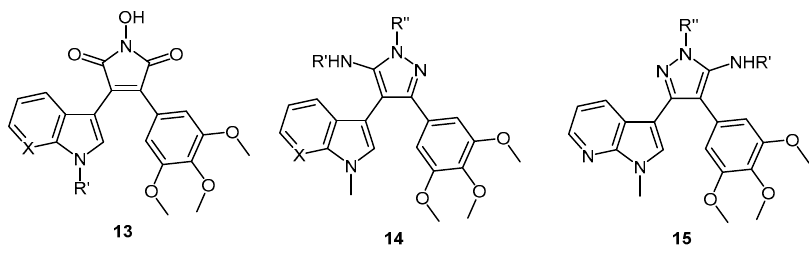
Figure 5. General structures of 3,4-diaryl maleimides 13 and 3,4-diaryl-5-aminopyrazoles 14 and 15 .